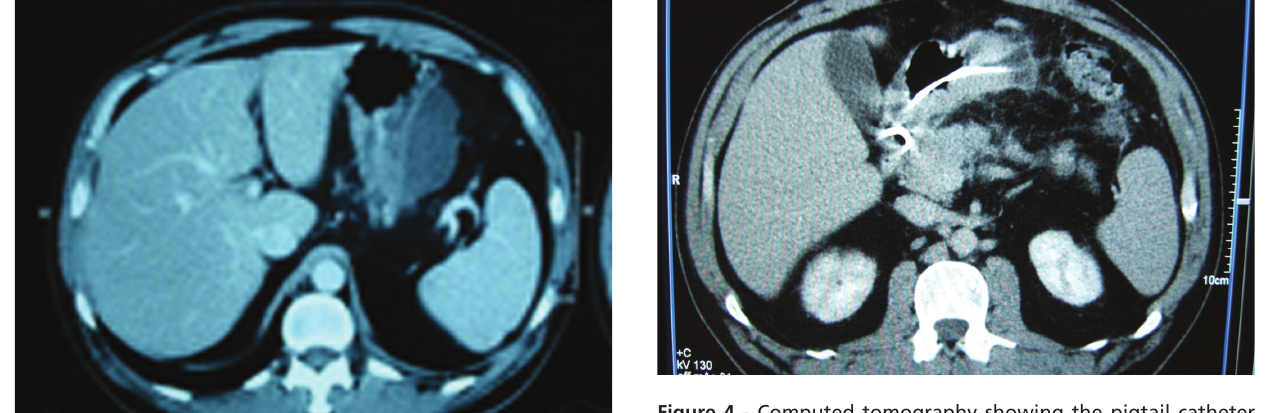
Figure 4 - Computed tomography showing the pigtail catheter left in the gastric wall abscess